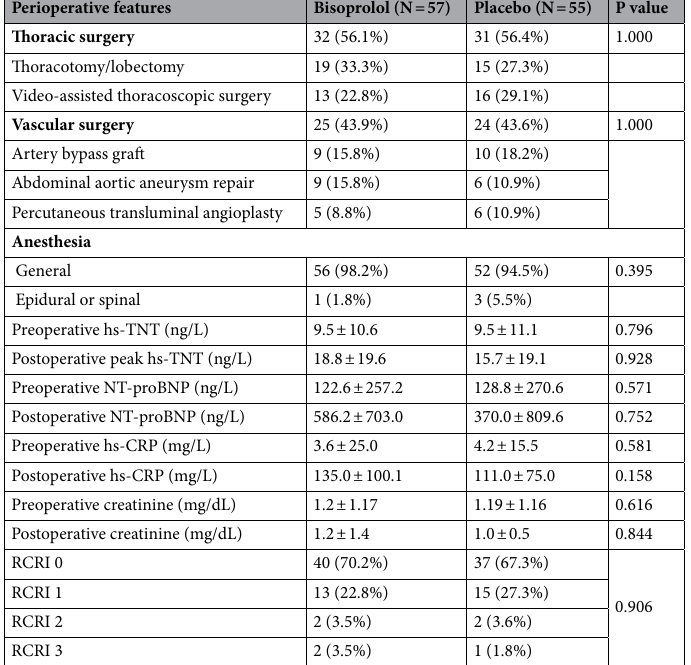
Table 2. Perioperative features between bisoprolol and placebo groups. hs-CRP high-sensitive C-reactive protein, hs-TnT high-sensitive troponin-T, NT-proBNP N-terminal-pro B-type natriuretic peptide, RCRI revised cardiac risk index.